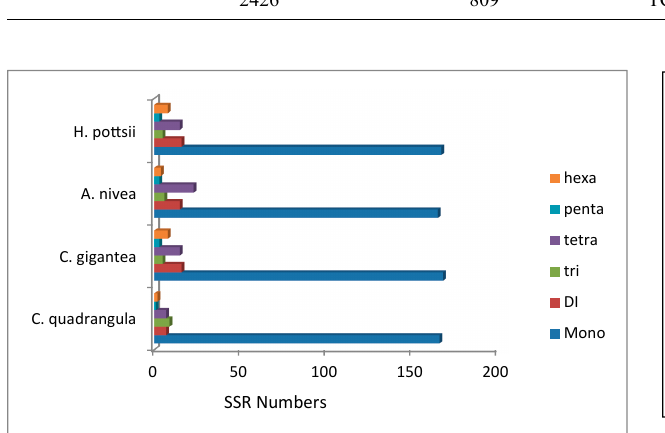
Fig. 5: Long repeats in four plastome genomes of Asclepiadoideae, where (P) indicates palindromic, (F) forward, (R) reverse, and (C) comple- ment repeats